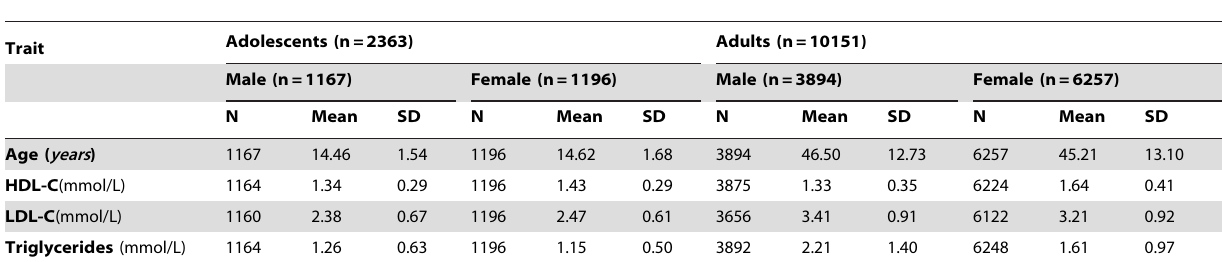
Table 1. Descriptive characteristics of genotyped adolescents and adults stratified by sex.